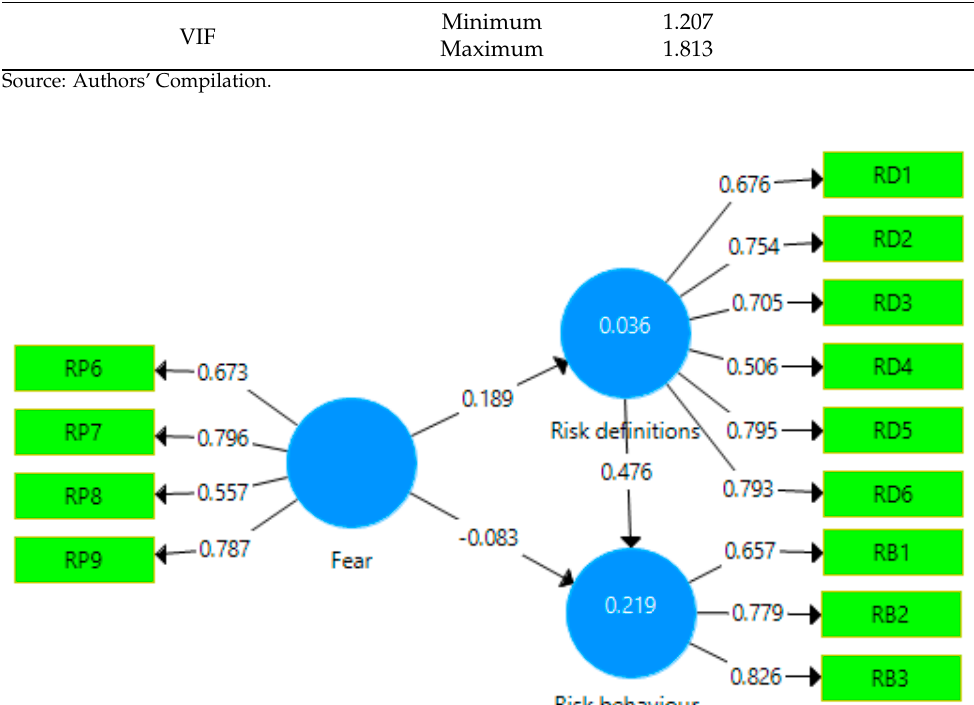
Figure 3. Model Two Structural Path Graph (Source: Authors’ Compilation).